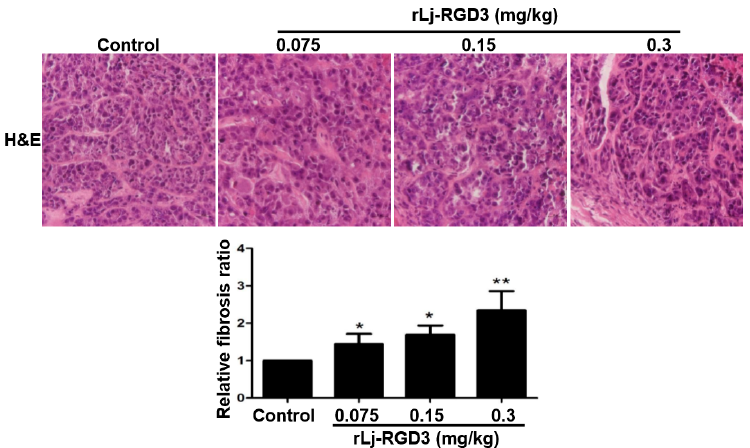
Figure 5. rLj-RGD3 changed the histological characteristics (400×) in the tumors of the HeyA8 xenografted mice. After treating rLj-RGD3, more gaps and fibrosis were observed in the H&E staining assay. The relative fibrosis ratio was calculated based on the formula mentioned in the methods and shown in a histogram. Relative to the control group: * p < 0.05; ** p < 0.01.